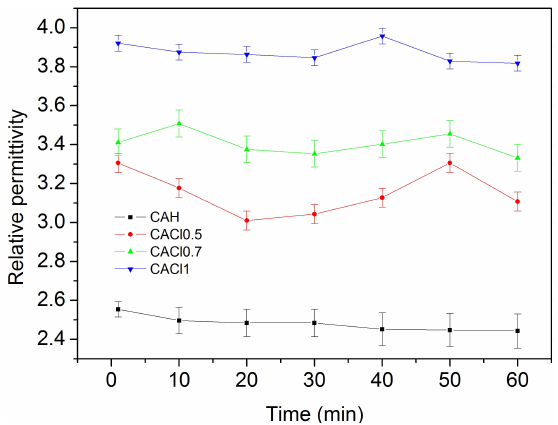
Figure 6. Time effect on CA’s electrical behavior when 0 M, 0.5 M, 0.7 M and 1 M NaCl solutions are added. Each data set is the mean of three.